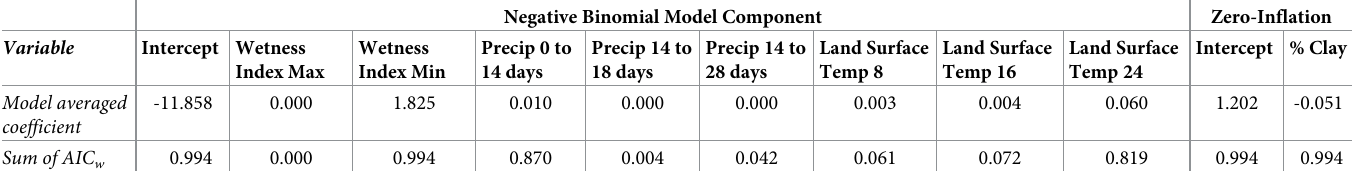
Table 2. Model averaged coefficients and sums of AIC w for each candidate variable using the 11 best models. AIC w values close to one indicate strong support for the importance of a